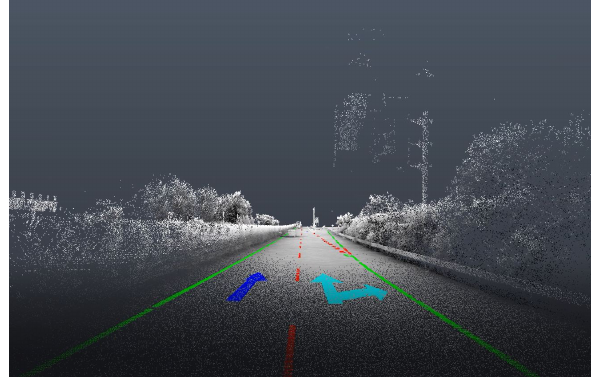
Figure 1. First-person perspective demonstration of